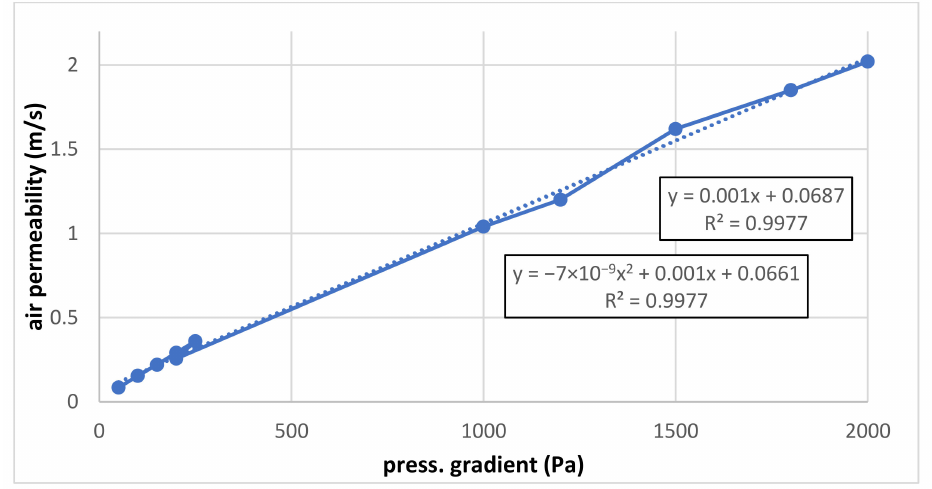
Figure 5. Common graph for both air permeability measurements (low- and high-pressure